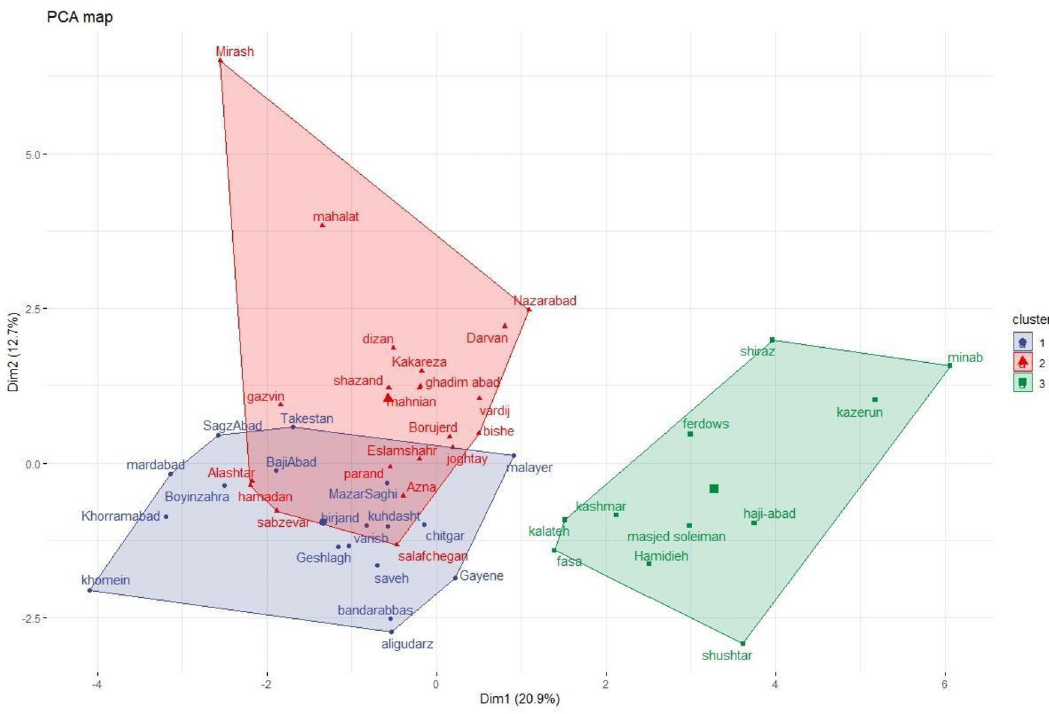
Figure 2. The association among measured variables and two first axis of PCA. The first and second dims explained up 21.4% and 12.9% of the total variation, respectively. The colours of vectors show the contribution rate of each variable to Dim1 and